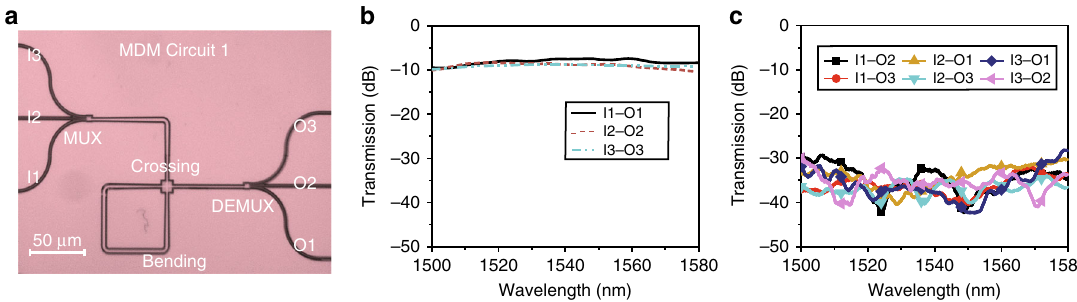
Fig. 5 Fabrication and experimental results of the mode-division multiplexing (MDM) circuit 1. a The top-view microscope image of the MDM circuit 1 consists of a multiplexer, 4 bends, a crossing, and a demultiplexer. b The measured insertion losses for different input/output ports. c The measured